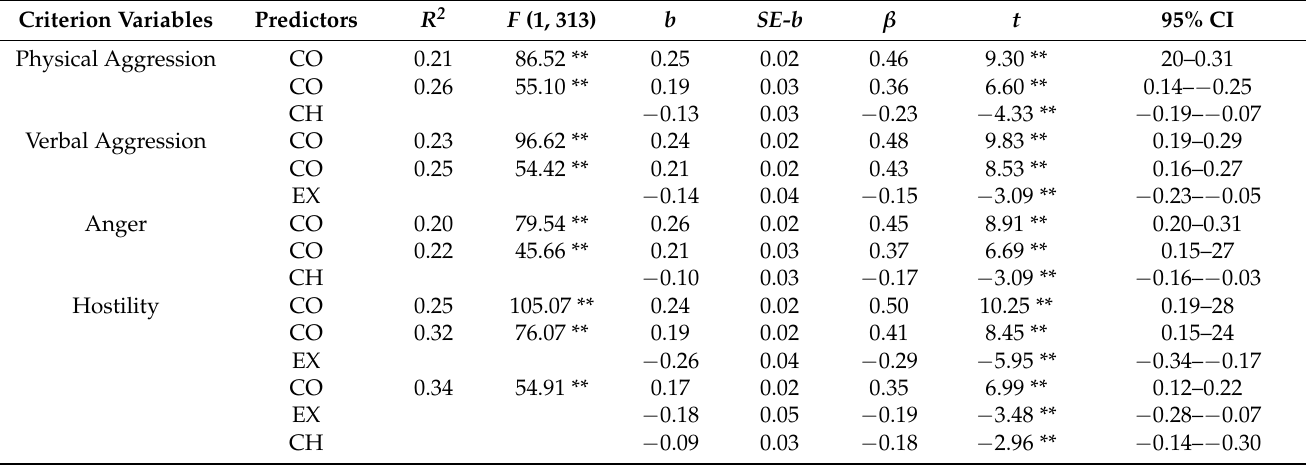
Table 4. Result of Stepwise Multiple Regression to Predict Aggression from Family